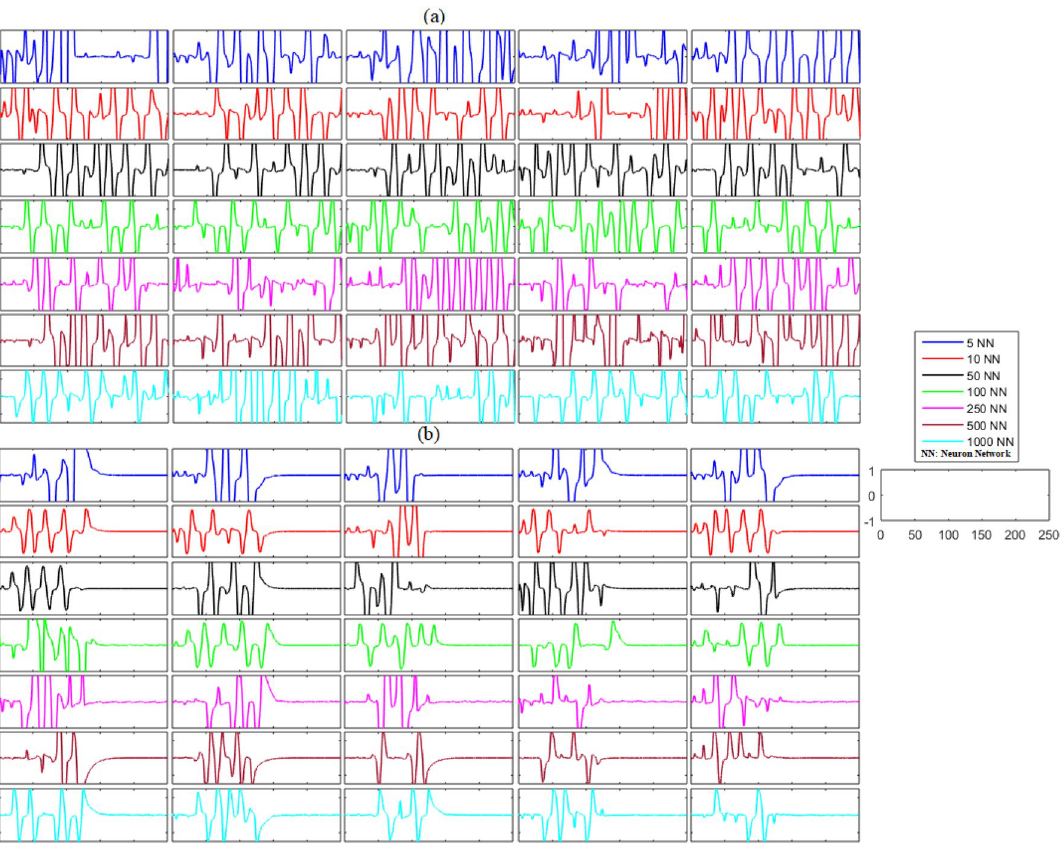
Figure 3. ( a ) Without control synchronization dynamics of the recovery variable states (y-states) of different time-delayed unidirectional FHN networks without noise. ( b ) Controlled synchronized error dynamics of the